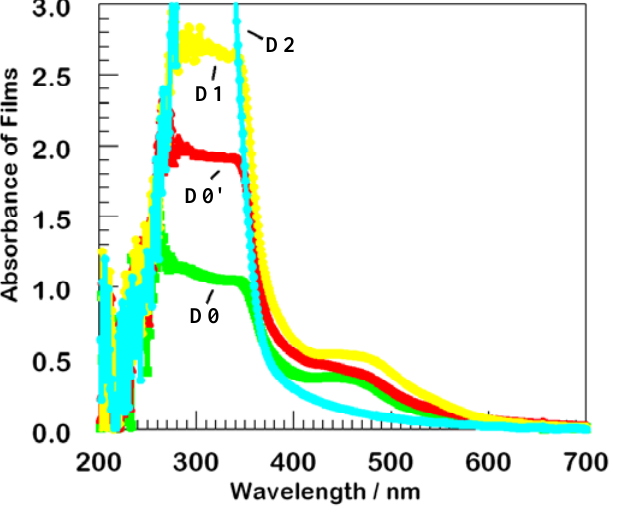
Figure 1. Absorption of thin films of the series of dendrimers on TiO generation film, D2, has the strongest absorption at 300 nm but the least absorption at 450 nm. Color coding remains the same in all figures.